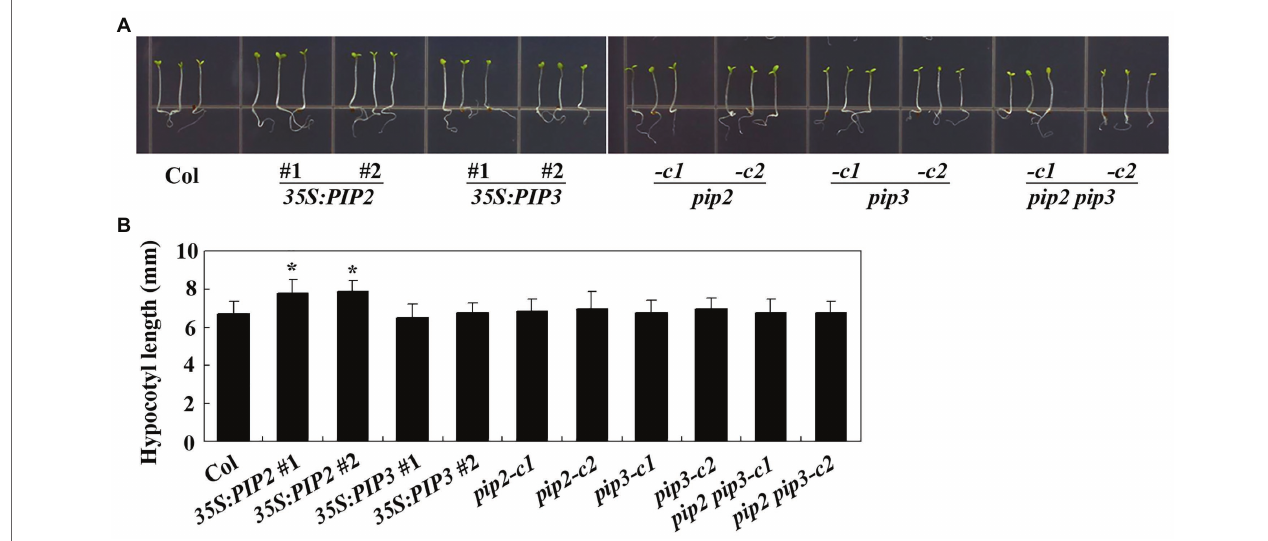
FIGURE 6 | PIP2 affects hypocotyl elongation. (A) Hypocotyl elongation in seedlings of the Col wild type, the 35S:PIP2 and 35S:PIP3 transgenic plants, and the pip2 , pip3 , and pip2 pip3 mutants. Seeds were sterilized and plated on 1/2 MS plates, kept at 4 ° C and in darkness for 2 days before transferred to a growth room and grown under dim light. Pictures were taken 4 days after the transfer by using a digital camera. (B) Hypocotyl length in seedlings of the Col wild type, the 35S:PIP2 and 35S:PIP3 transgenic plants, and the pip2 , pip3 , and pip2 pip3 mutants. Hypocotyl length of 4-day-old seedlings grown under dim light were measured. Data represent the mean ± SD of 29–42 seedlings. *significantly different from that of the Col wild type seedlings (student’s t -test, p < 0.001). The experiments were repeated three times with similar